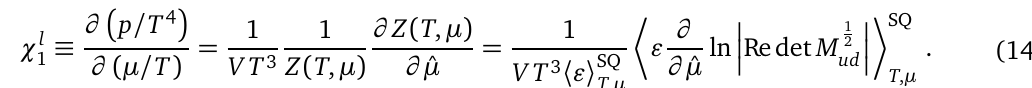
Figure 3: The renormalized chiral condensate (left) and the light quark number-to- light quark chemical potential ratio (right) as a function of ( µ T = 140 MeV with the 2stout improved staggered action at N τ = 6. Data from simu- lations at real µ (black) are compared with analytic continuation from simulations B at imaginary µ (blue). In the left panel the value of the condensate at the crossover B = 0 is also shown by the horizontal line. The simulation data cross temperature at µ B / T ≈ this line at µ B